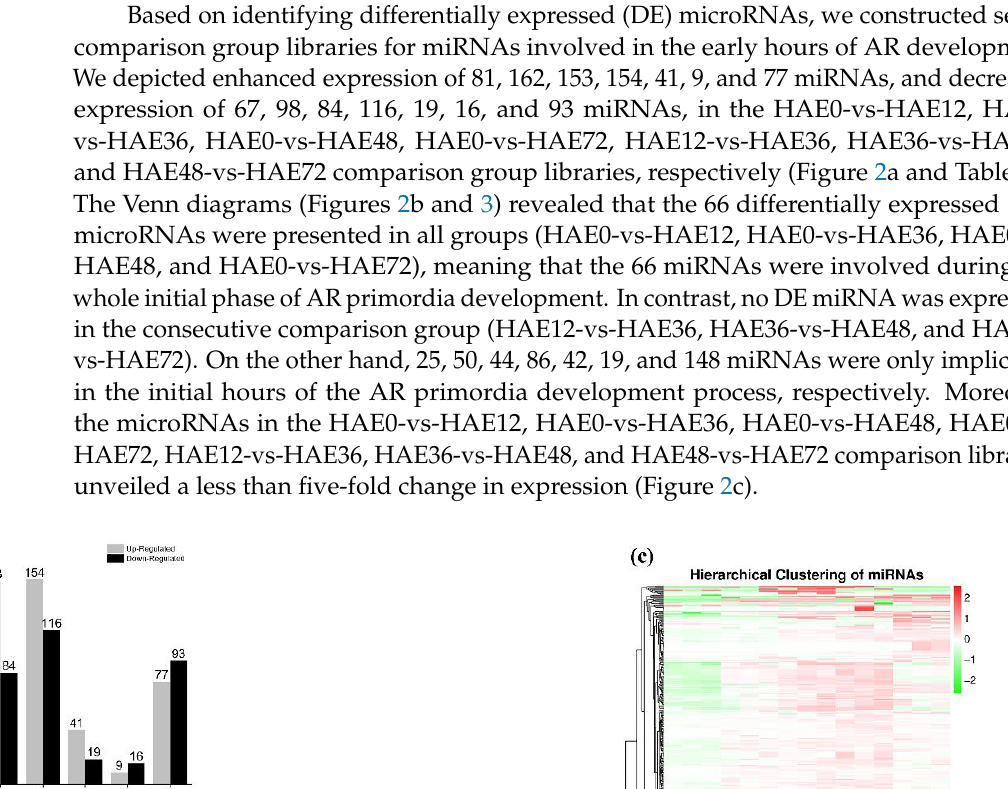
Figure 3. Expression profile and identification of DE miRNAs during IBA-dependent AR formation in dark-pretreated micro-shoot cuttings of tetraploid R. pseudoacacia L. The figure depicts the shared and unique (known and novel) DE miRNAs of the associated transcriptome analyses. The overlap between the DE miRNAs was identified following 0 HAE, 12 HAE, 36 HAE, 48 HAE, and 72 HAE